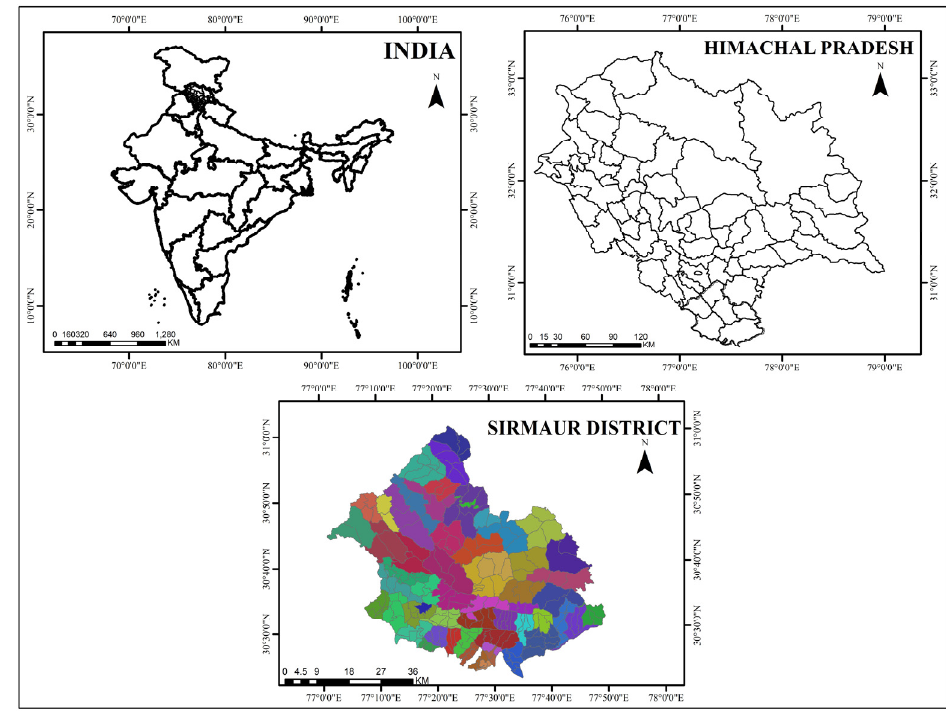
Figure 1. Study area.